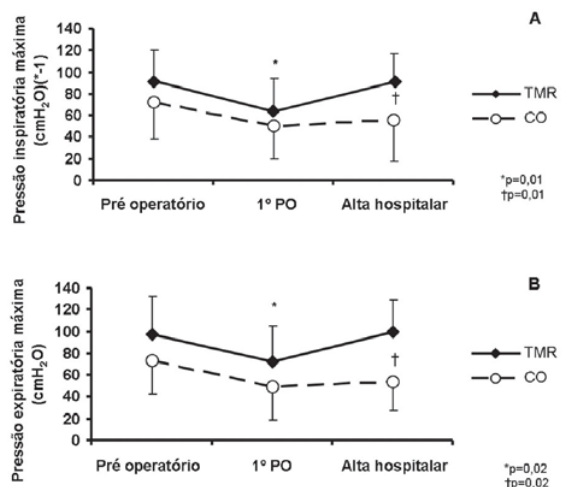
Fig. 2 - (A) Pressão inspiratória máxima (Pimáx) nos dois grupos em três momentos: pré-operatório, primeiro dia de pós-operatório (1º PO) e momento da alta hospitalar; (B) Pressão expiratória máxima (Pemáx) nos dois grupos em três momentos: pré- operatório, primeiro dia de pós-operatório (1º PO) e momento da alta hospitalar. CO = grupo controle; TMR = grupo treinamento muscular respiratório; cmH O = centímetros de água; *1º PO vs. 2 pré-operatório; † TMR vs.